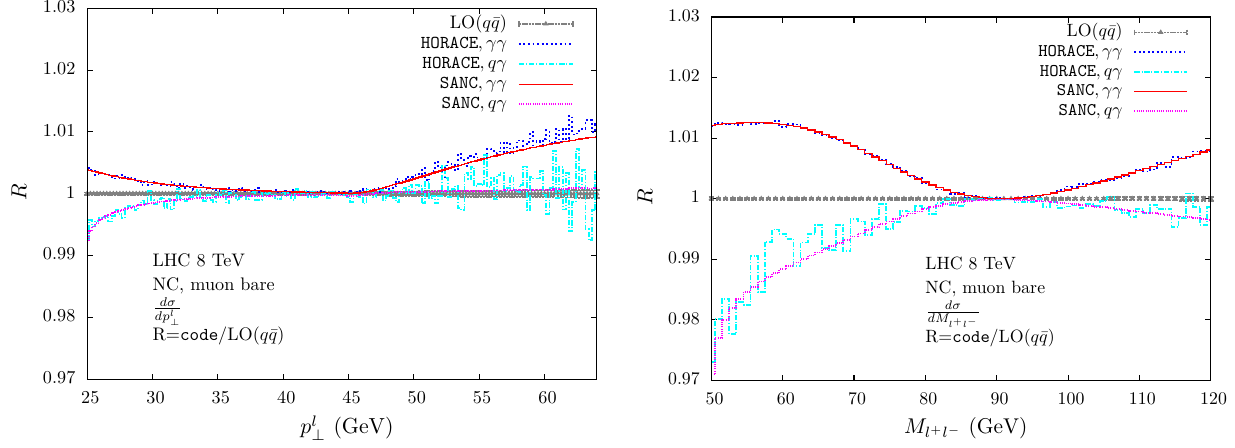
Fig. 25 Relative effect of photon-induced subprocesses in pp → μ + μ − + X ,comparedtotheLO q ¯ q resultsinthe G μ scheme,botheval- uated with the NNPDF23_lo_as_0130_qed PDF set at the 8 TeV LHC with ATLAS/CMS cuts. Results are shown for the lepton trans-